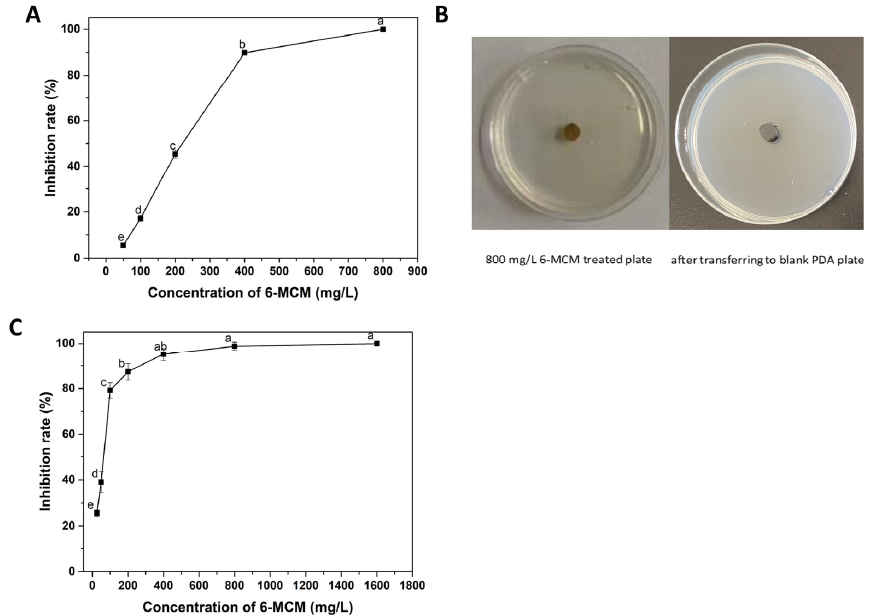
Figure 3. The inhibitory effect of 6 ‐ MCM on the mycelial growth ( A , B ) and spore germination ( C ) of V. mali . The bars represent the standard error of the mean (n = 3), and letters (a–e) represent the difference between the different concentrations of 6 ‐ MCM. 6 ‐ MCM, 6 ‐ methylcoumarin. Probit analysis with SPSS was used to determine the EC 50 values and the virulence regression equations of 6 ‐ MCM against V. mali (Table 1). The virulence regression equa ‐ tion against mycelial growth inhibition of V. mali was Y = 3.406X − 7.726 (R 2 = 0.968), with the EC 50 value 185.49 mg/L, while the virulence regression equation against spore germi ‐ nation inhibition was Y = 2.059X − 3.578 (R 2 = 0.979), with the EC 50 value 54.62 mg/L. Table 1. Virulence regression equation of 6 ‐ MCM against V. mali . Virulence Regression